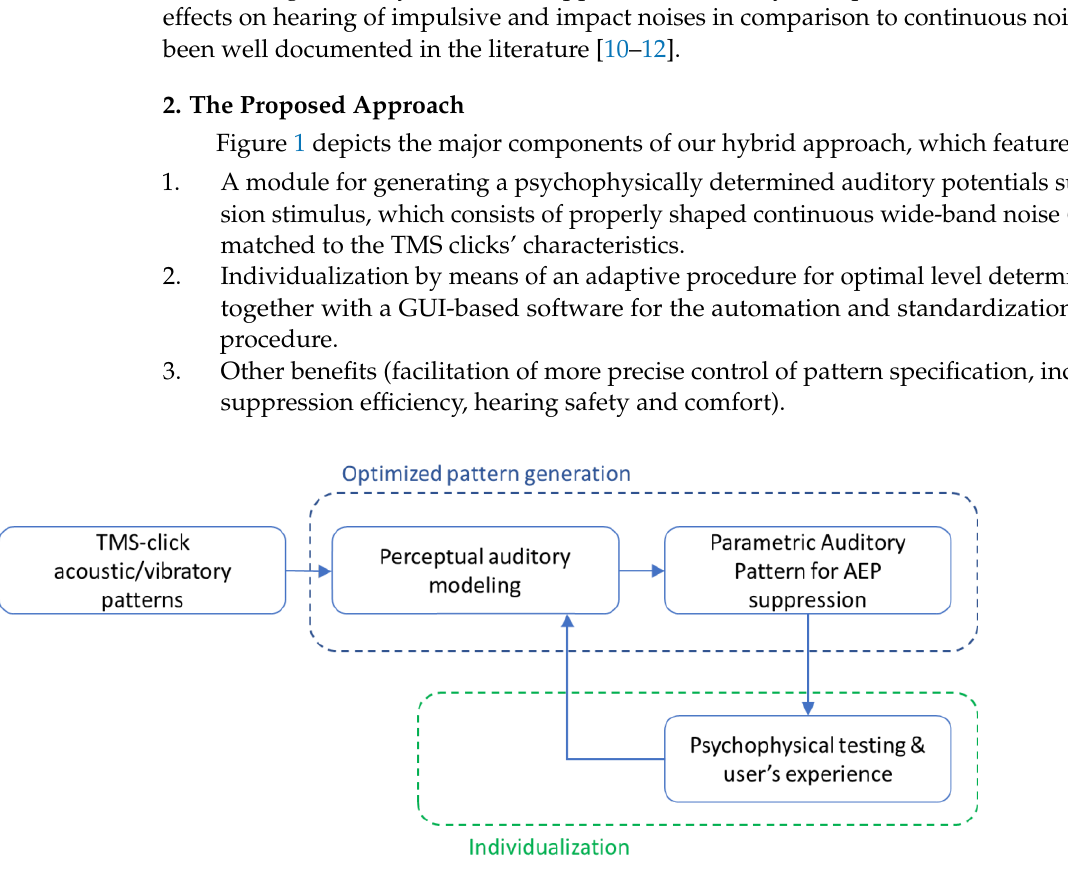
Figure 1. Schematic representation and components of the proposed AFTS approach.